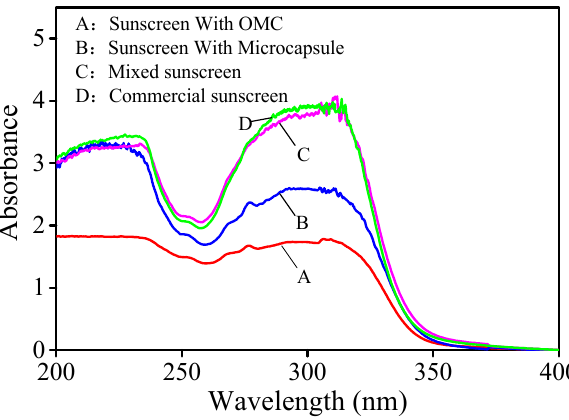
Figure 13. Ultraviolet absorption effect of sunscreen with the OMC